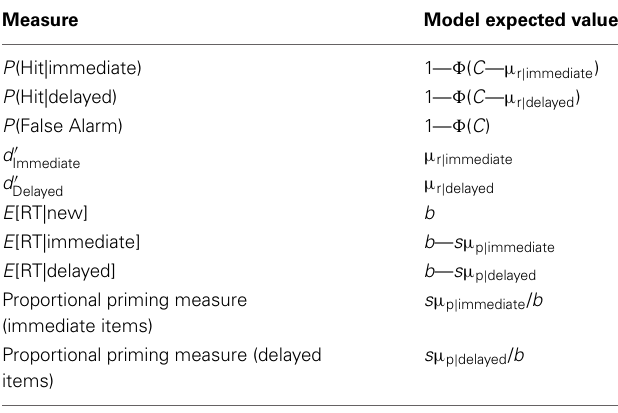
Table 1 | Expected values for measures of recognition and priming in the models.